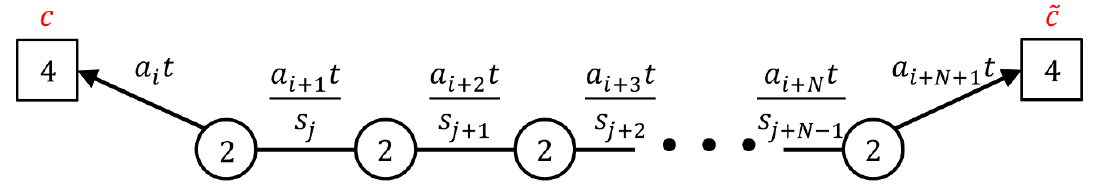
Figure 16 . The (cid:12)elds added in (cid:8)-gluing. The baryonic operators a i t=s j introduced in the gluing are the ones we give vacuum expectation value to. Not all operators exist in every model, and the spectrum depends on the (cid:13)uxes and also puncture properties in case there are ones. Thus, it is expected that the (cid:13)ow will depend non trivially on the (cid:13)uxes. All (cid:12)elds added in the gluing have an R-charge 1. This R-charge is the one naturally inherited from 6 d and not necessarily the conformal one. In addition, the representation under the two SU(4)’s depends on the type of the punctures glued and can be either fundamental or